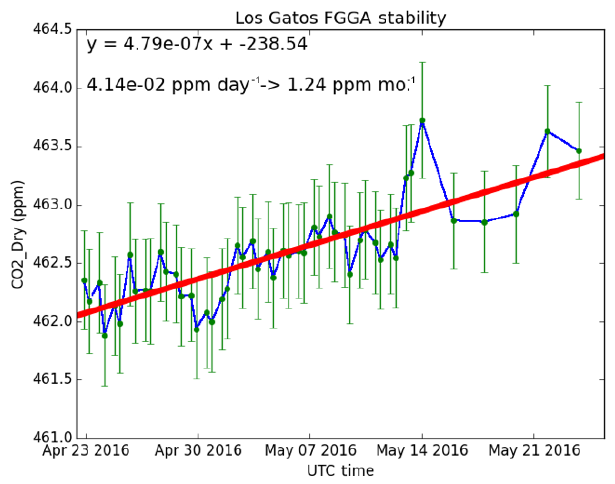
Figure 3. Stability of the Los Gatos Fast Greenhouse Gas Analyzer shown over a 30-day period. Excess breathing air with a fixed CO 2 concentration was introduced periodically using a mass flow con- troller. The mean of each calibration period is plotted in green with the standard deviation as error bars. The blue line is the linear inter- polation between each calibration point, and the red line is a linear fit of each calibration point over the entire time series. The red line is subtracted from the dataset to account for the drift of the analyzer over this